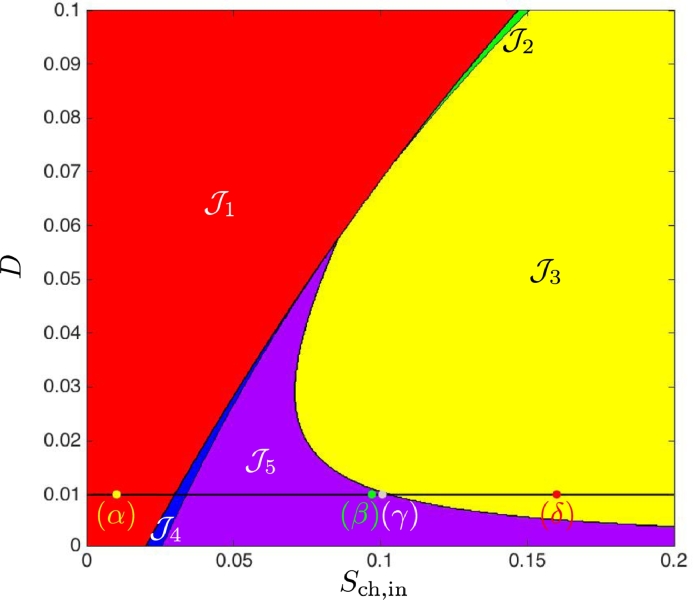
Numerical analysis for the existence and stability of steady-states for case (a), with maintenance. This is a magnification for 0 < D < 0.1, showing the presence and extent of region J5 undetectable by the analytical method. The coordinates labelled (α)−(δ) are subsequently used to simulate the system dynamics, as shown in the proceeding Fig. 10.